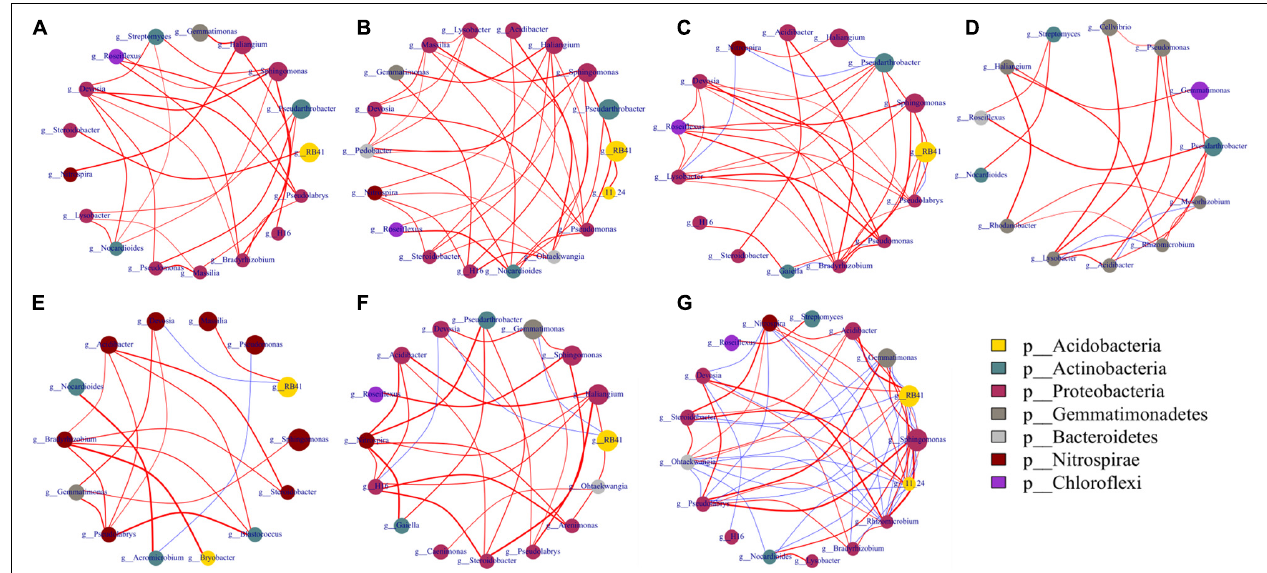
FIGURE 6 | Networks of co-occurring bacterial genera based on correlation analysis. Co-occurrence network was performed using the top 20 abundant genera of bacterial and fungal communities based on Spearman’s rank analysis ( ρ > 0.6) and significant correlations ( p < 0.05). Circles represent nodes whose size indicates the relative abundance, the thickness of each edge is proportional to the value of Spearman’s correlation coefficients, and node color represents taxonomy at the phyla level. Edges indicate co-occurrence between nodes colored either blue for negative or red for positive. (A) A1, A2, A3; (B) B1, B2, B3; (C) C1, C2, C3; (D) D1, D2, D3; (E) A1, B1, C1, D1; (F) A2, B2, C2, D2; (G) A3, B3, C3, D3. Treatments included A, non-treated control; B, fenaminosulf; C, kasugamycin; D, dazomet. Numbers 1, 2, and 3 represent samples collected at 14, 55, and 110 days after soil treatment,